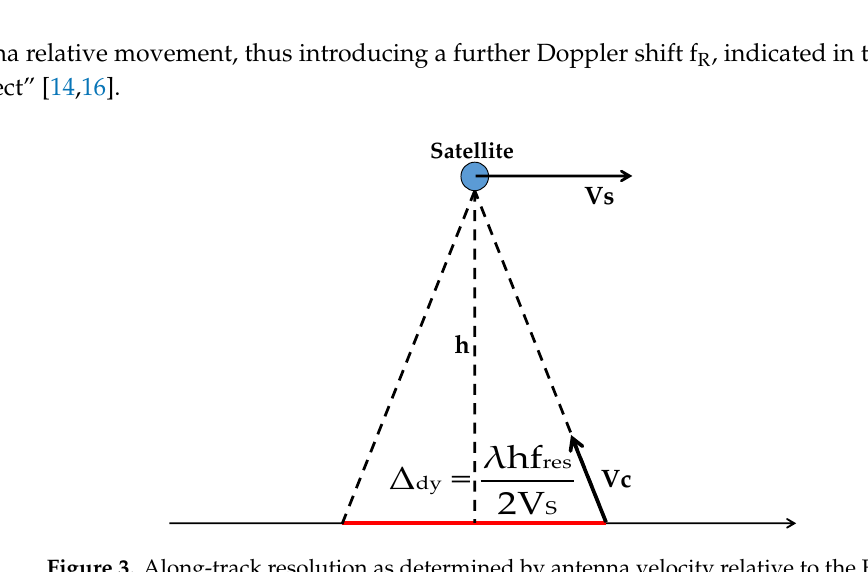
Figure 3. Along-track resolution as determined by antenna velocity relative to the Earth.